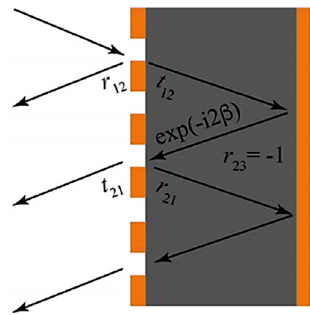
Figure 2. Multi − reflection diagram of the metamaterial layer and base reflection layer [33].